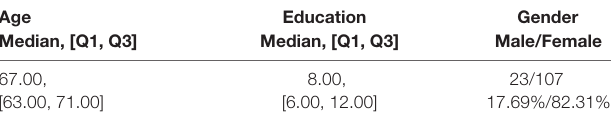
TABLE 1 | Demographic data of elderly participants as age, education years and